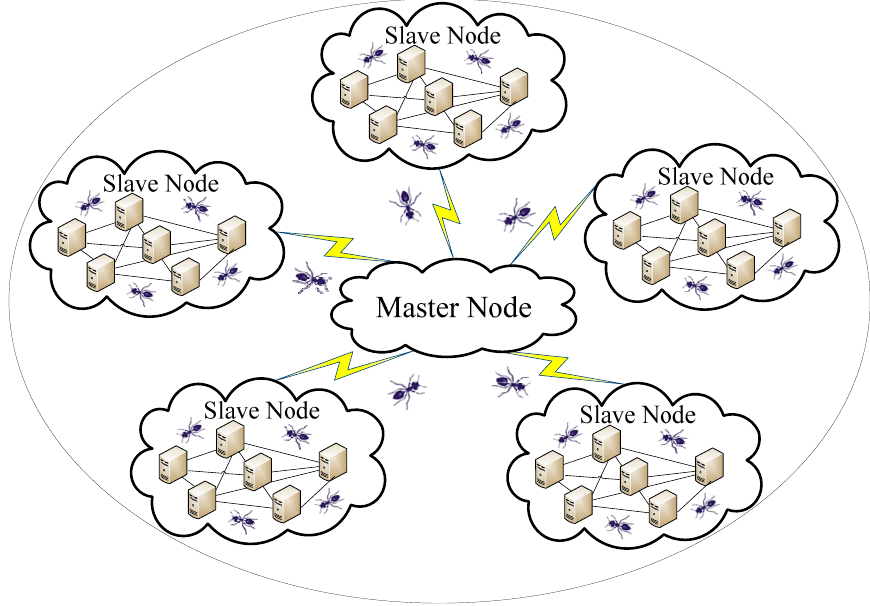
Figure 1. Network topology of virtual resources in cloud